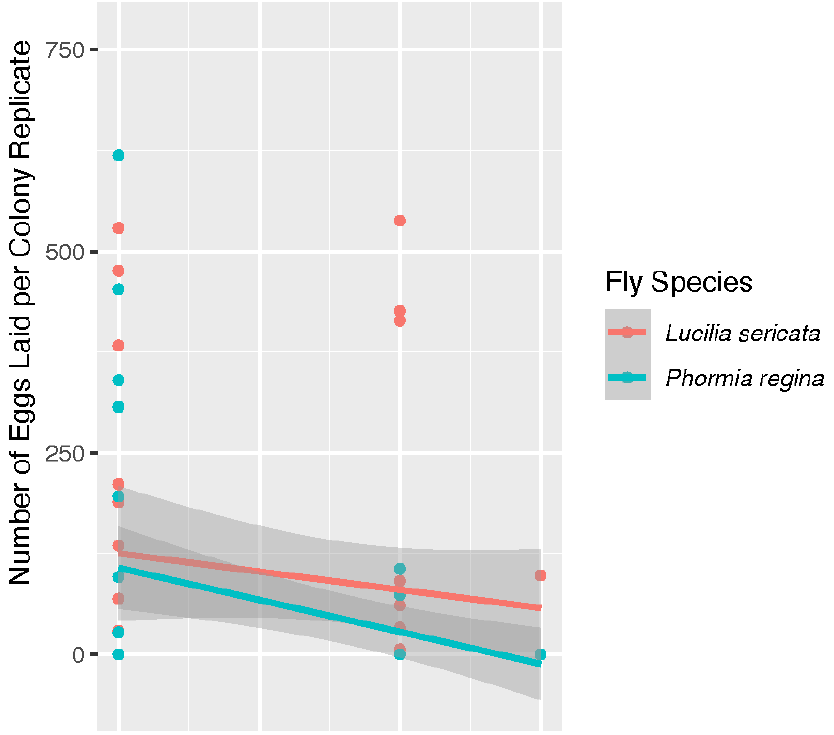
Figure 4. A plot of the number of eggs laid by Lucilia sericata (light red) and Phormia regina (teal) at temperatures at 40 °C, 42 °C, and 43 °C. In this analysis, fly species was not a significant factor with a p = 0.112 while temperature was significant with a p = 0.009.